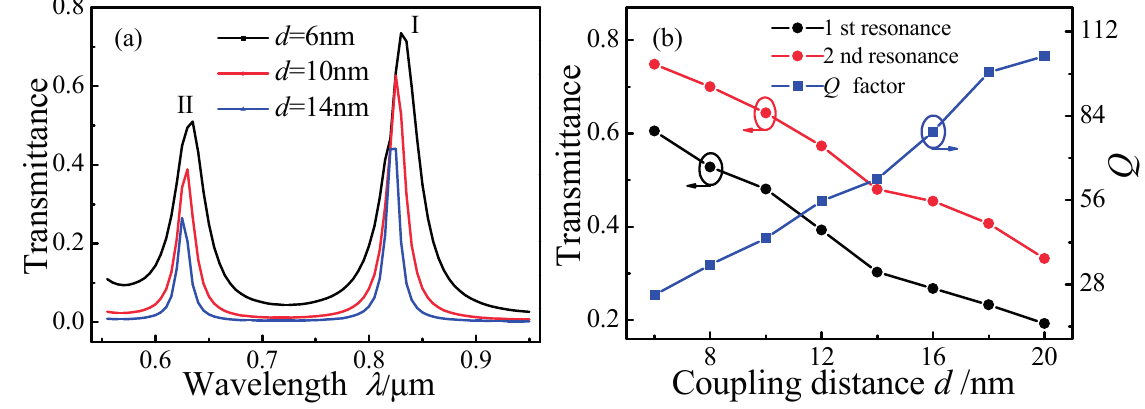
Figure 5. Transmission spectra of MIM waveguide-coupled ring resonators as a function of coupling distance d . ( a ) Spectra for d = 6 nm, 10 nm, and 14 nm; ( b ) Transmittance and Q factor as a function of